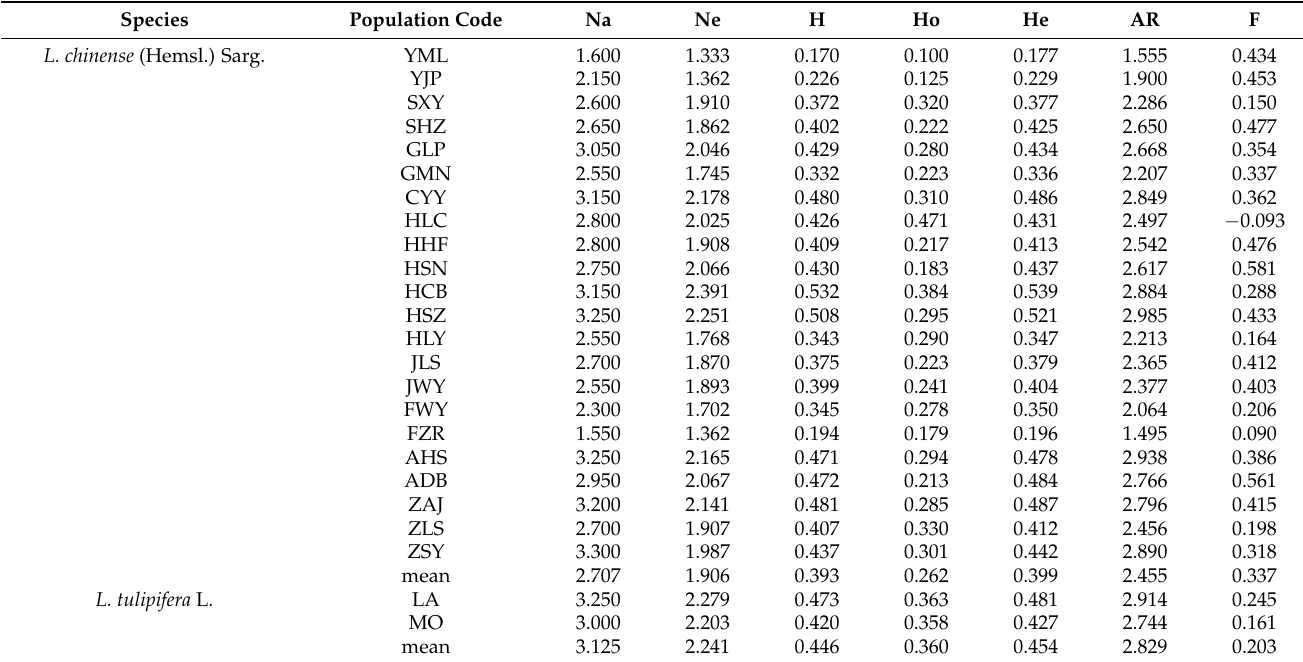
Table 2. Mean values of genetic diversity for 20 microsatellite loci in 22 L. chinense geographic populations and 2 L. tulipifera geographic